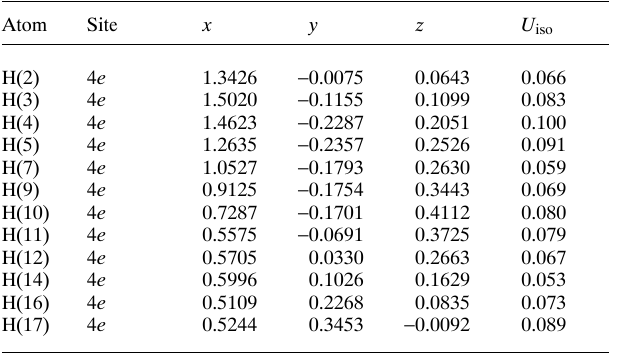
Table 2. A tomic coordin a tes a nd displ a cement p a r a meters (in Å 2 ) . Table 2. C